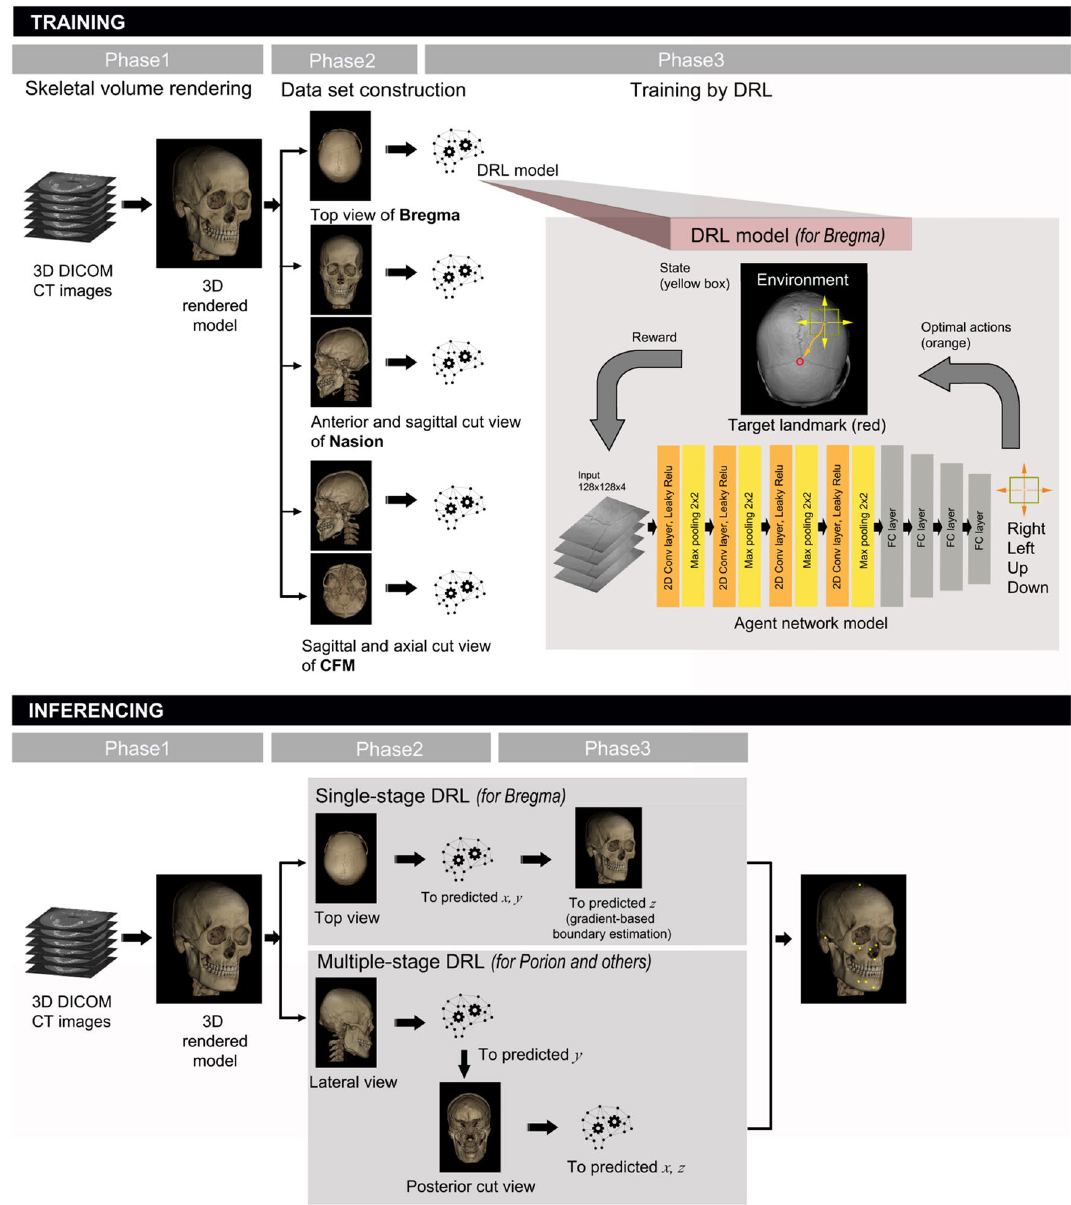
Figure 4. Schematic diagram of the proposed 3D cephalometric landmark detection framework using deep reinforcement learning (DRL). The training stage included data import and volume rendering in the first phase, anatomical image view adjustment for landmarks in the second phase, and training with DRL agents in the third phase. The latter is depicted in detail in the upper box with a drawing to illustrate the agent navigating toward the target landmark. The inferencing stage included both single- and multi-stage DRL, starting with the same 3D model rendering in phase 1, followed by single-stage or multi-stage DRL in the second phase, and finalized by gradient-based boundary estimation for single-stage DRL, or by repeated DRL and landmark prediction for multi-stage DRL in the third Single or multiple views were appropriately produced for each landmark and DRL training was performed without data augmentation on the 20 training group models (as shown in the second and third phases of the training stage in Fig. 4). DRL training was organized in such a way that the environment responds to the agent’s action and the agent continuously acts to get maximum rewards from the environment 17 , i.e., to reach the closest location to the reference coordinate (as shown in the third phase of training in Fig. 4). At the inferencing stage, landmark prediction was performed by both single-stage and multi-stage DRL to evaluate the landmark- or stage-related accuracy level (as shown in the first phase of inference stage in Fig. 4). Single-stage DRL refers to one pass of the DRL algorithm, followed by gradient-based boundary estimation, for landmark detection. The multi-stage DRL was defined as the application of a single-stage DRL algorithm for more than two passes, without the gradient-based boundary estimation. The single-stage DRL was not applicable